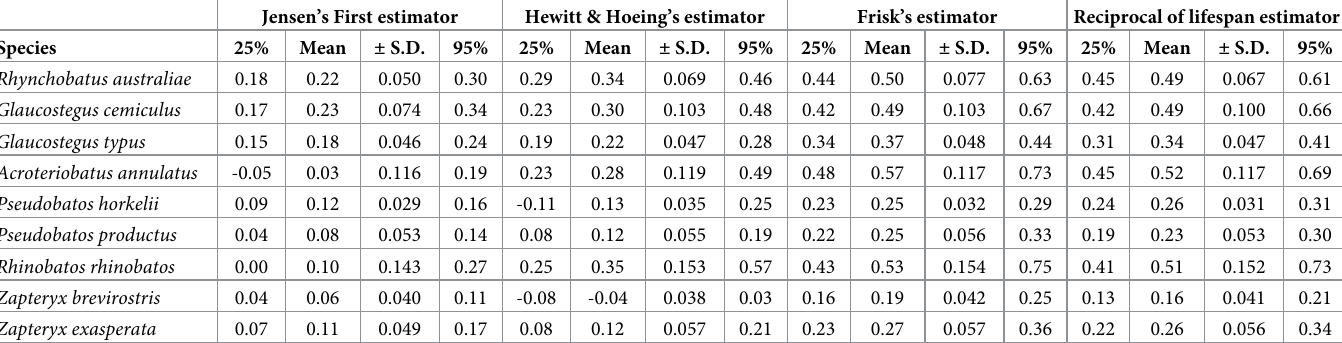
Table 4. Estimates of r max (year -1 ) for nine species of shovelnose rays using four methods of estimating natural mortality. The mean ( ± standard deviation S.D.) and 25% and 95% quantiles of r max values are reported for each species and natural mortality estimator. Jensen’s First